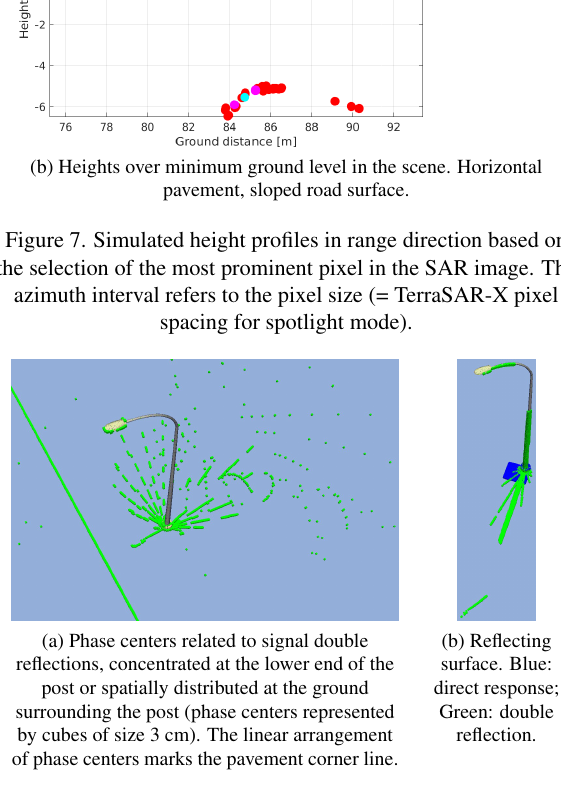
Figure 8. Projection of phase centers and reflecting surfaces into the light pole 3D model.